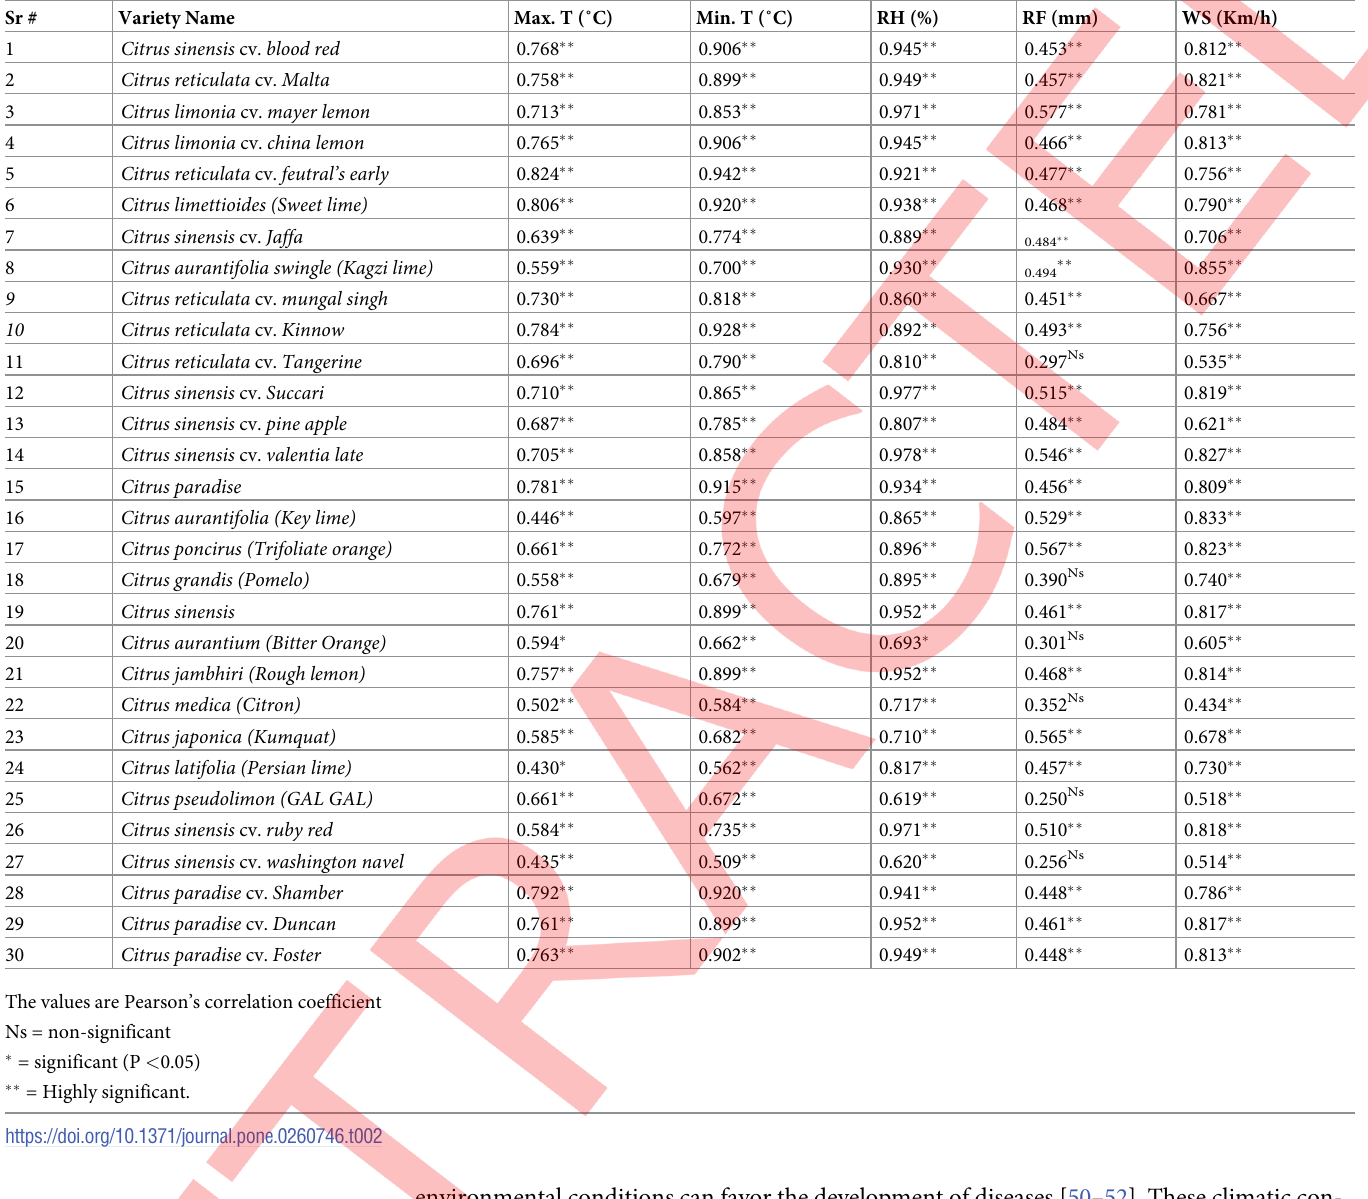
Table 2. Pearson correlation matrix of various environmental factors with citrus canker disease on different citrus varieties during